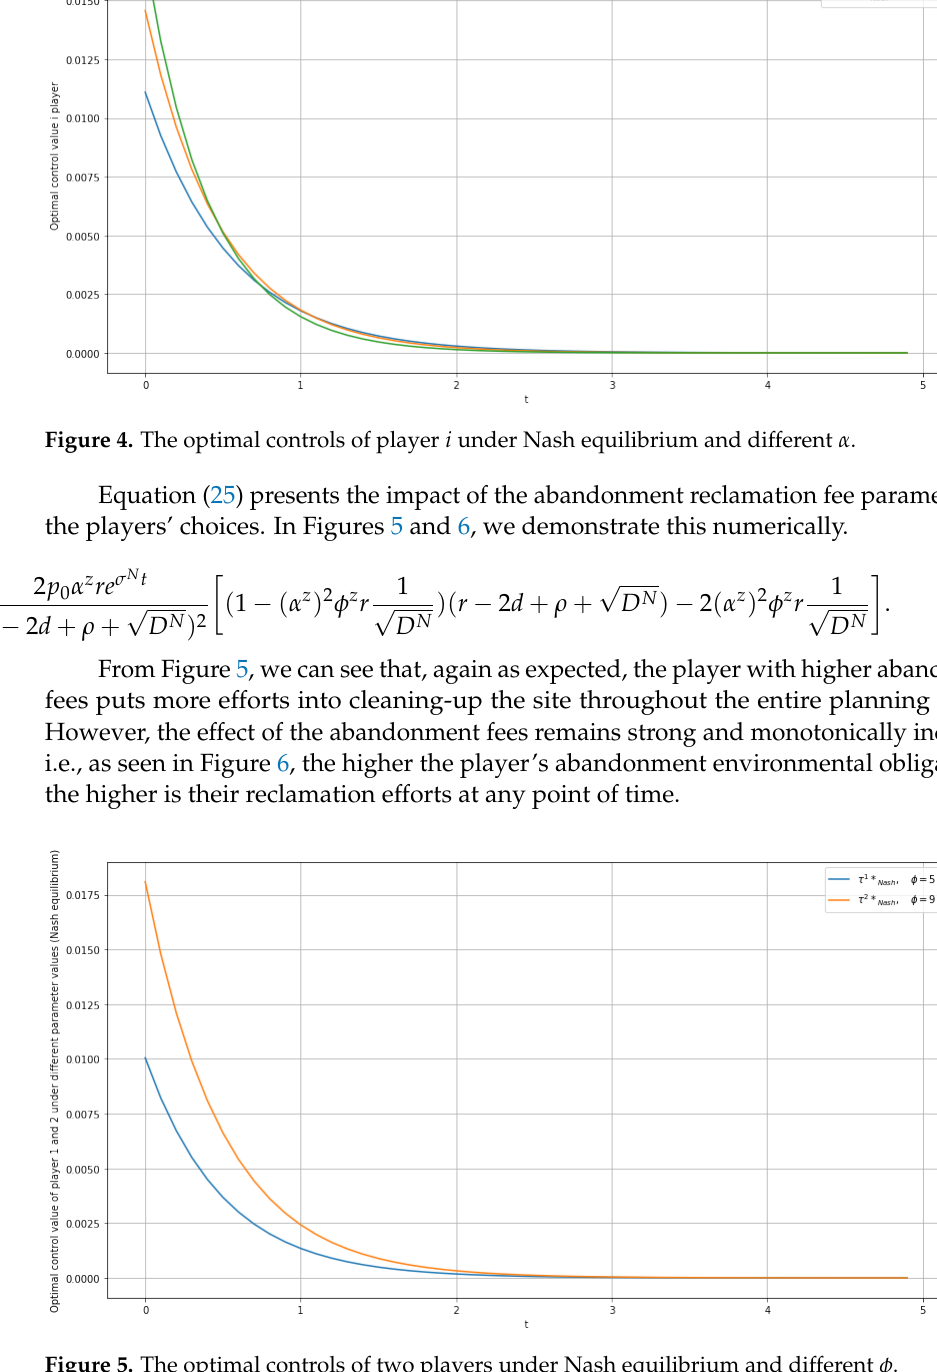
Figure 5. The optimal controls of two players under Nash equilibrium and different φ